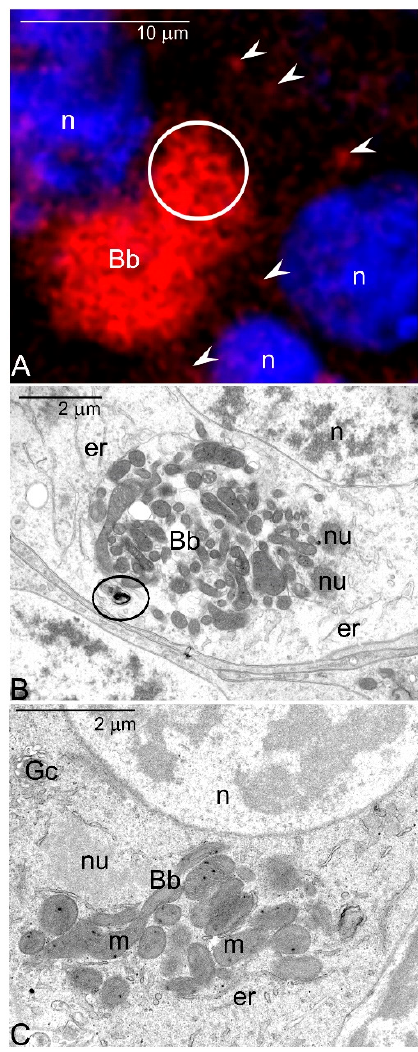
Figure 1. Balbiani body (Bb) of Thermobia domestica . ( A ) Meiotic oocyte incubated with MitoTracker ® Deep Red FM, counterstained with Hoechst 33342. Bb mitochondria are highly active, whereas those present outside this organelle assemblage exhibit lower activity (arrowheads). Note that that Bb mitochondria are elongated and ramified (encircled). Confocal microscope. ( B ) Medial section trough the Bb in developing oocyte. Note numerous mitochondria (m), accumulations of nuage material (nu), endoplasmic reticulum cisternae (er) and degenerating mitochondria outside the Bb (encircled). Transmission electron microscope (TEM). ( C ) Medial section through the Bb in apoptotic oocyte. Note nuage accumulation (nu), endoplasmic reticulum cisternae (er), Golgi complex (Gc), and swollen/enlarged mitochondria. TEM. Oocyte nucleus (n).